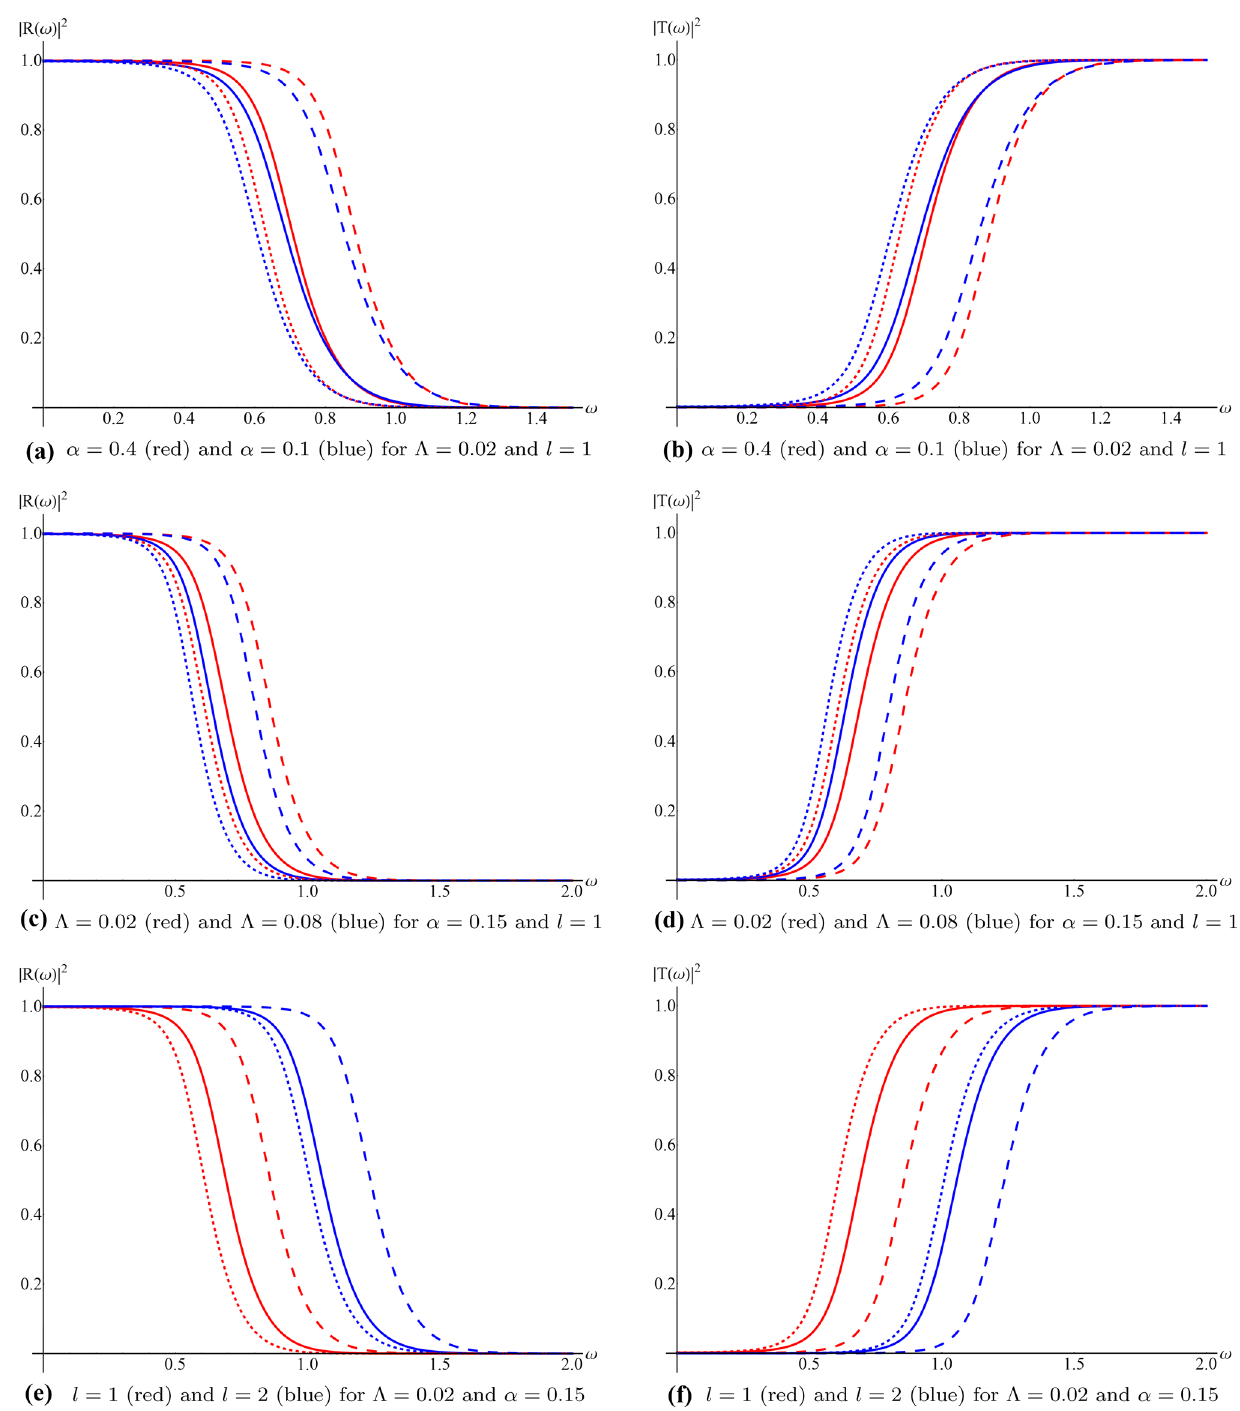
Fig. 4 The figure plots the reflection and transmission coefficient of the scattered scalar (solid), electromagnetic (dotted) and Dirac (dashed) wave for M = 0 . 5 and different parameter